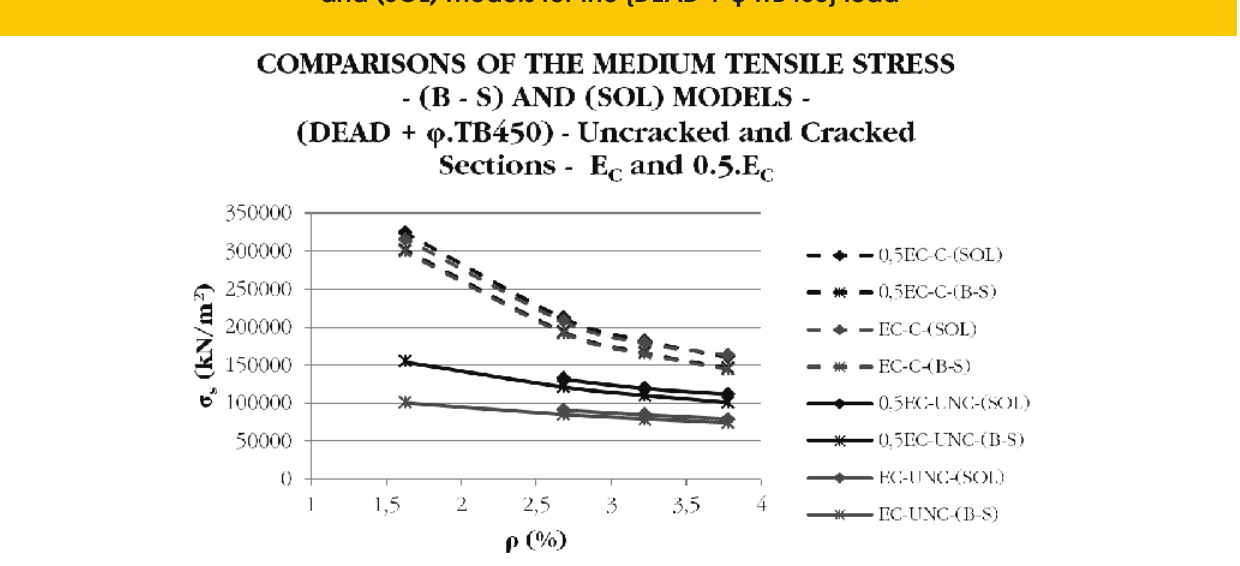
Figure 24 – Comparisons of the medium tensile stress in (B-S) and (SOL) models for the {DEAD + φ .TB450}